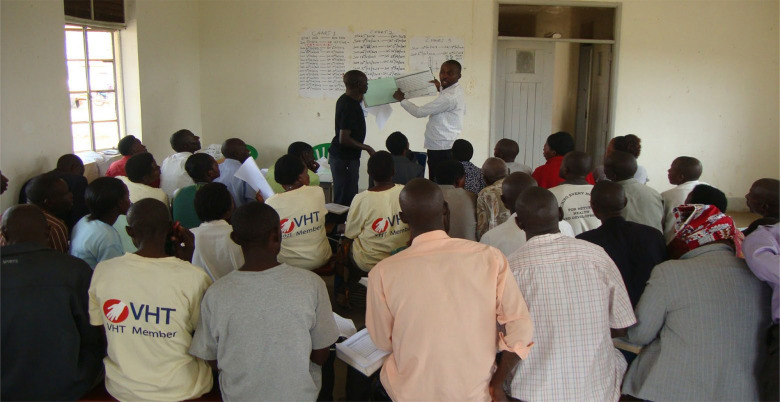
A supervisor shows village health team members how to fill in the iCCM register during a quarterly review meeting. Photo credit: © 2013 Edmound Kertho